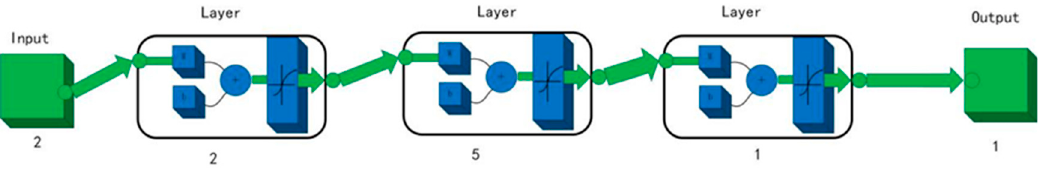
Figure 4. ( a ) Compressive strength fitting equation of 3d; ( b ) Compressive strength fitting equation of 7d; and ( c ) Compressive strength fitting equation of 28d.